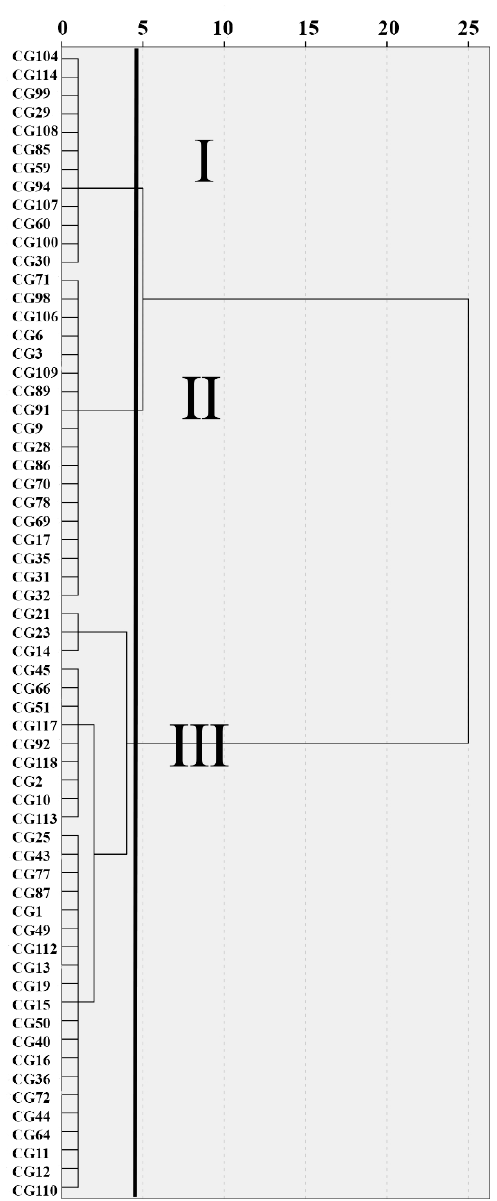
Figure 6. Cluster analysis of 62 germplasm accessions based on HII value. The line with HII less than 35 belongs to group Ⅰ , the line with HII greater than 35 and less than 50 belongs to group Ⅱ , and the line with HII greater than 50 belongs to group Ⅲ .